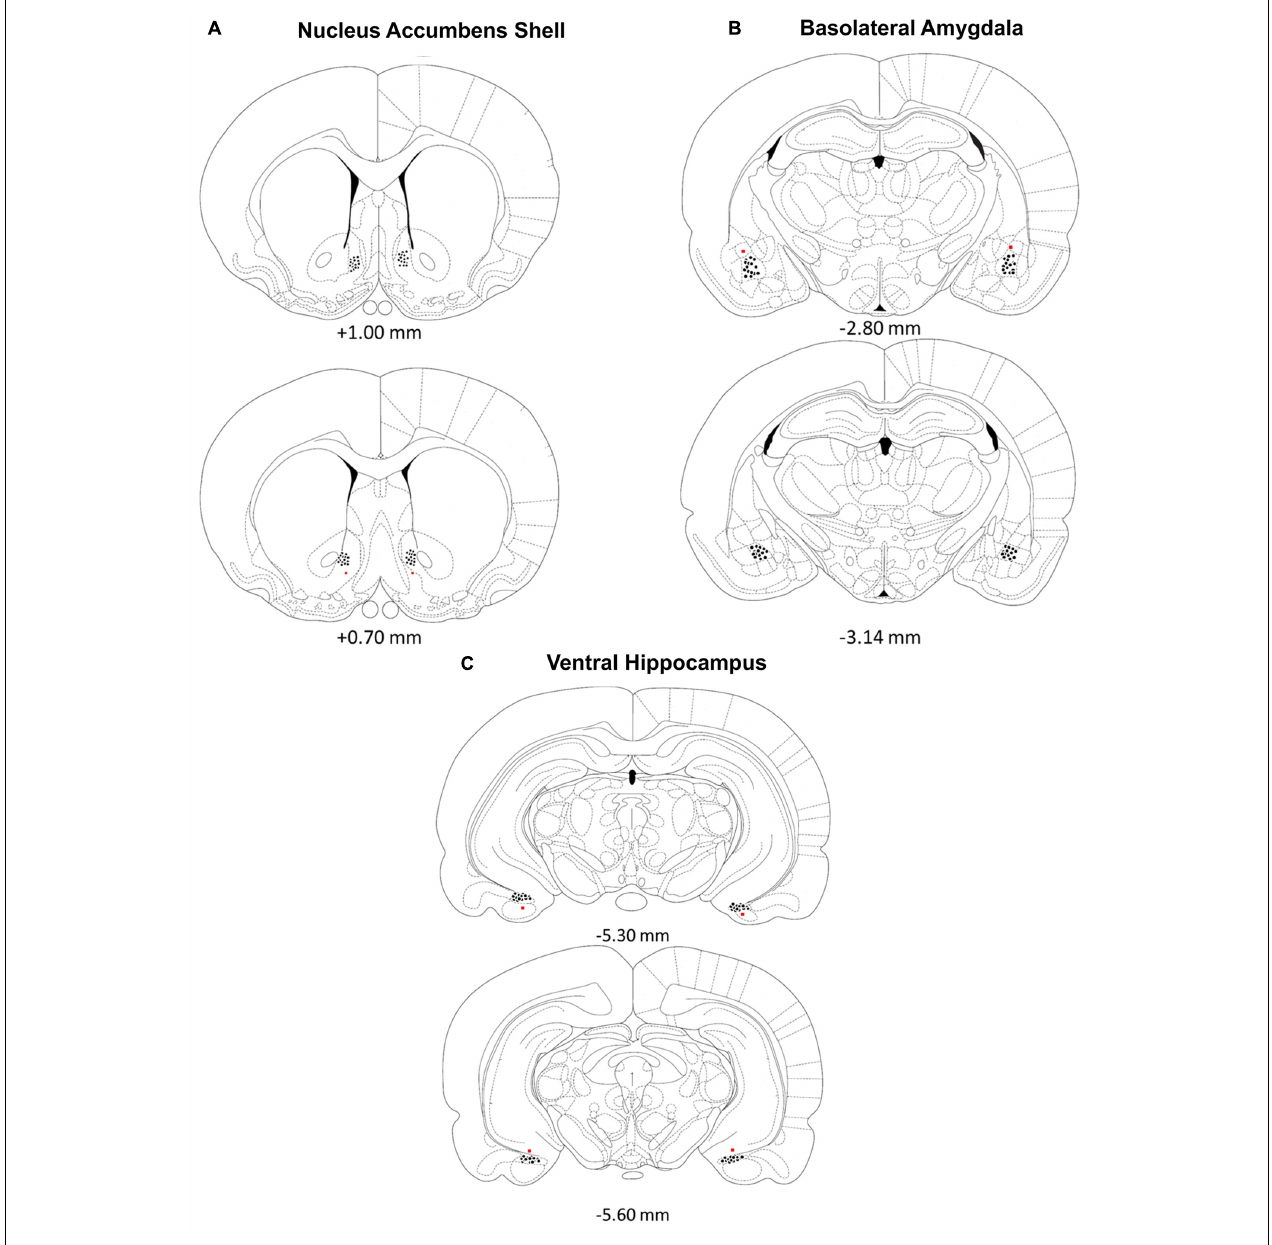
FIGURE 1 | (A–C) Location of injection needle tip placements in the (A) nucleus accumbens shell, (B) basolateral amygdala and (C) ventral hippocampus. Brain diagram from “The Rat Brain in Stereotaxic Coordinates”; adapted from Paxinos and Watson,